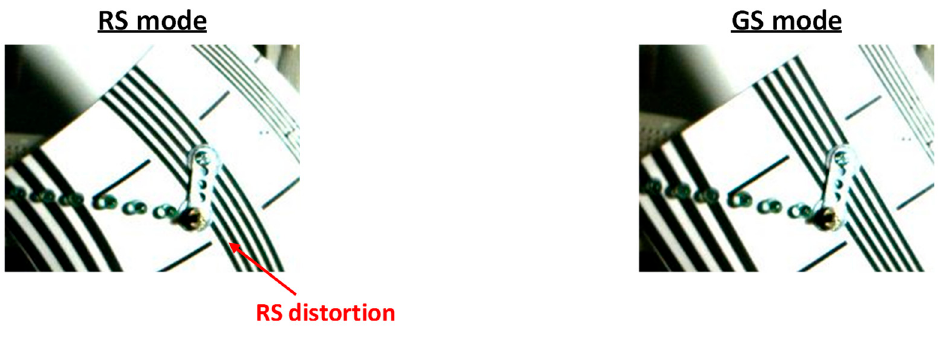
Figure 13. Sample images captured by rolling shutter (RS) and global shutter (GS) modes.